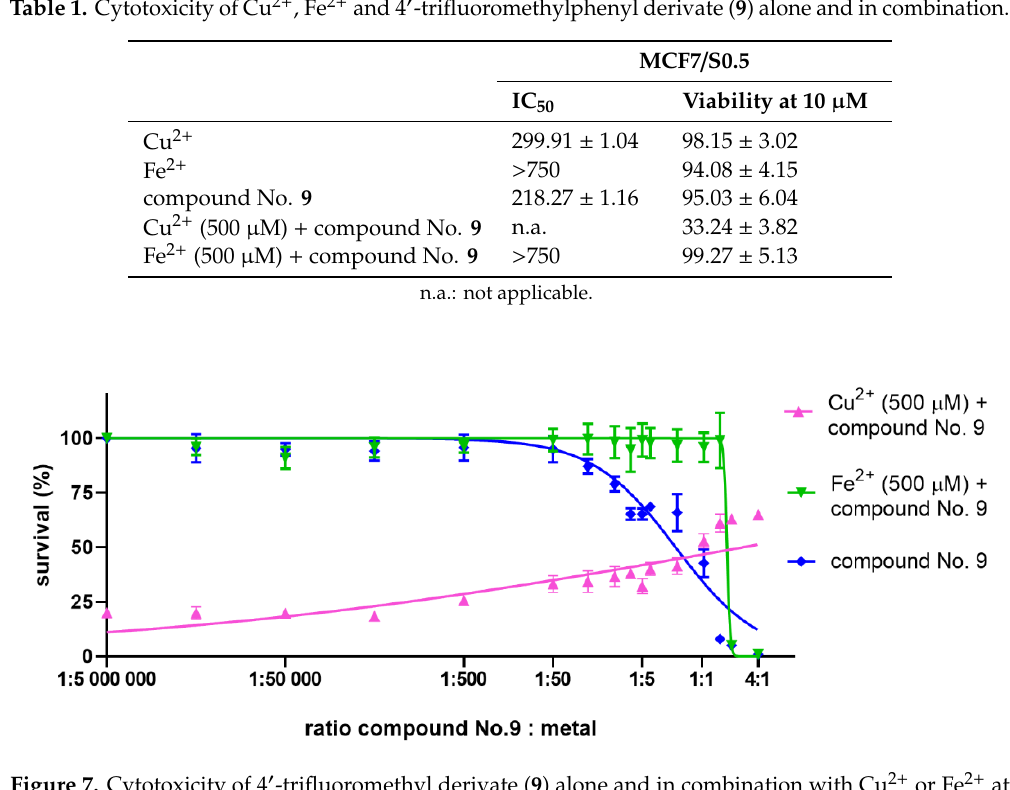
Figure 7. Cytotoxicity of 4′-trifluoromethyl derivate ( 9 ) alone and in combination with Cu 2+ or Fe 2+ at concentration 500 µM. Viability was determined by cell viability assay after 48 h treatment in MCF7/S0.5 cells. Vehicle-treated cells were set as 100% viability.